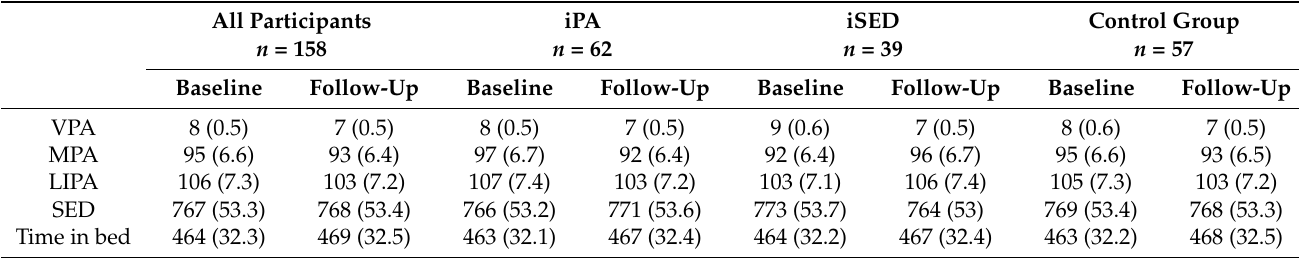
Table 2. Baseline and 6-month follow-up values for minutes spent in 24-h movement behaviors (compositional mean and % of 24-h in parentheses).